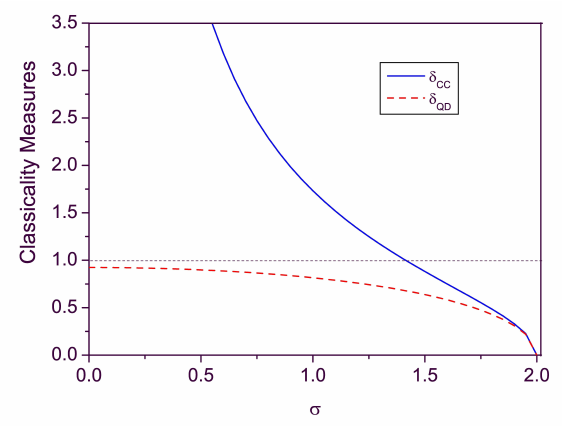
Figure 2: Conductivity dependence of δ CC (solid blue line) and δ QD (dashed red line). Short dashed line is a reference line which corresponds to 1. We used (cid:126) = 1 , ω = 1 , (cid:15) = 1 , and β = 1